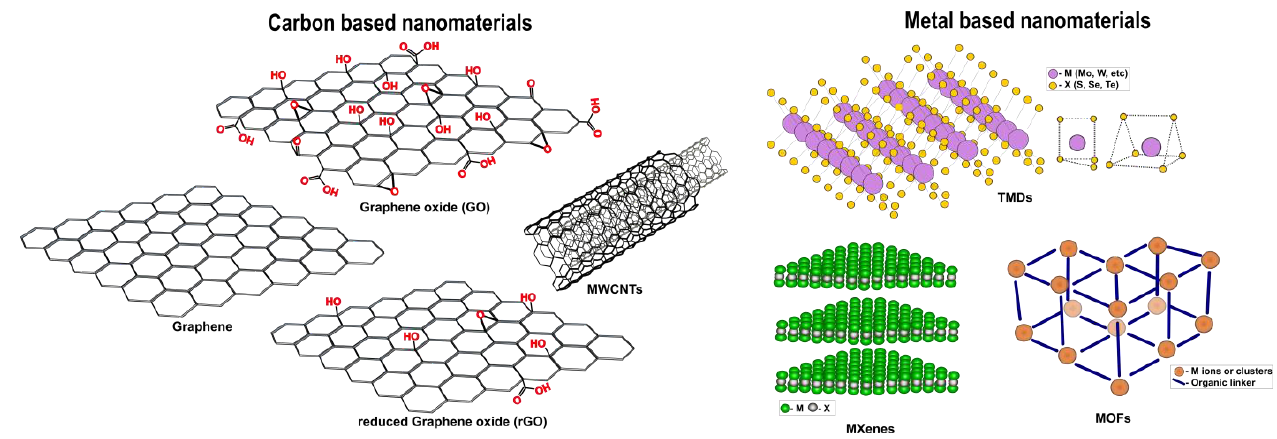
Figure 7. Various 2D (graphene- and metal-based) nanomaterials for sensitivity enhancement in SPR assays. SPR